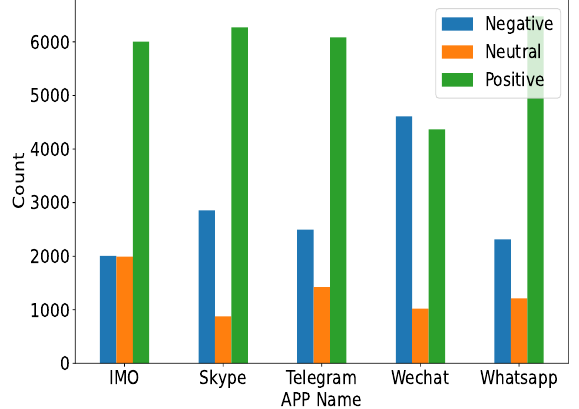
Figure 8. Overall statistics of the calling